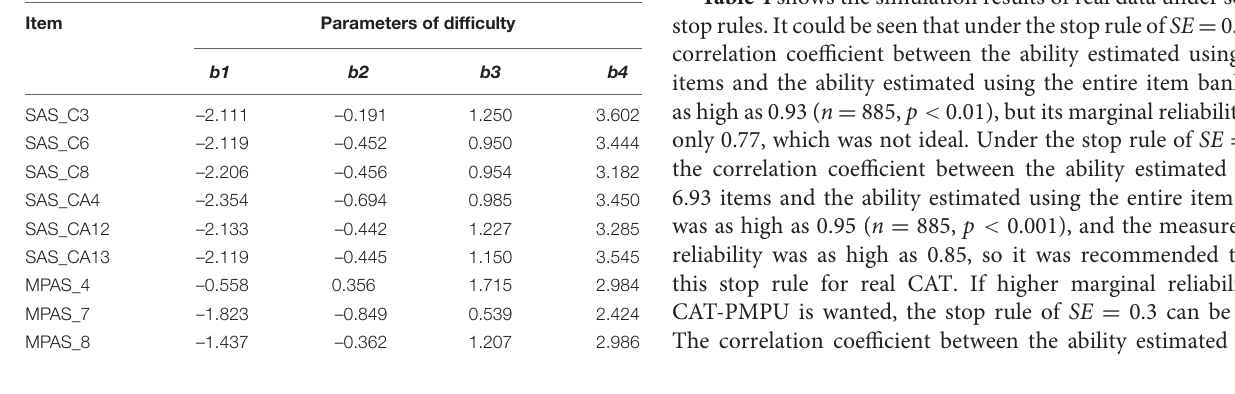
TABLE 3 | Difficulty parameters of some